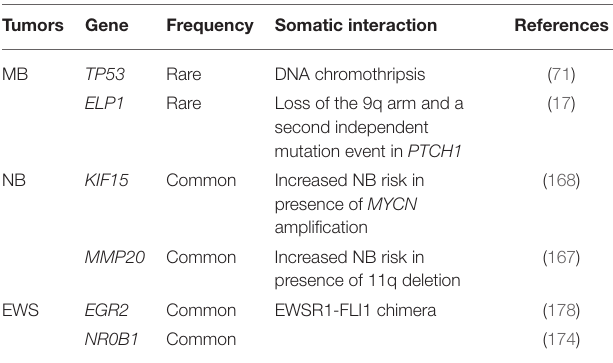
TABLE 4 | Germline–somatic interactions identified in genes predisposing to pediatric tumors. Tumors